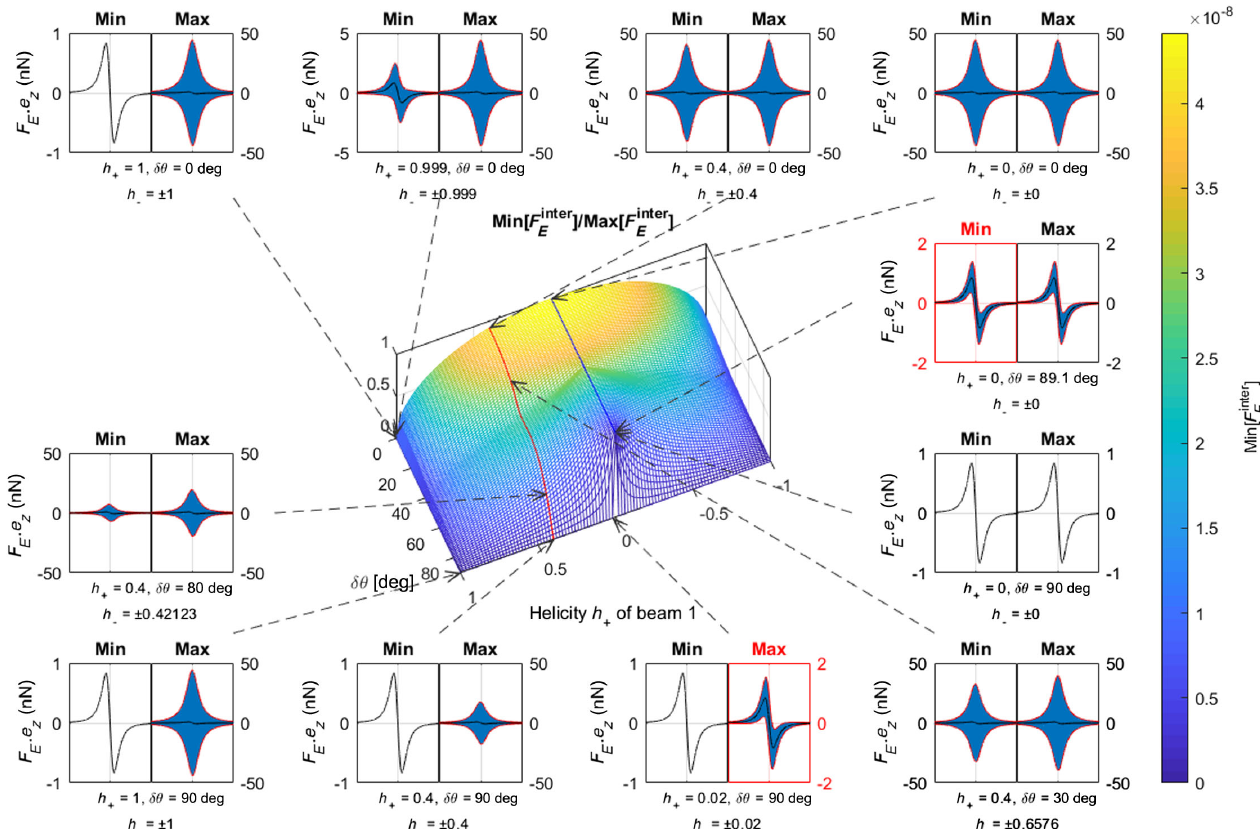
FIG. 10. General ð h þ ; h − ; δ ; δθ Þ polarization parameter space describing the achiral electric force-field landscape whose equations are detailed in Appendix A in terms of the ratio between the minimum and the maximum amplitude of the interference forces. All insets display forces along the optical axis from both sides of the waist over a length of 20 μ m. Note that the force amplitudes of the insets vary from configuration to